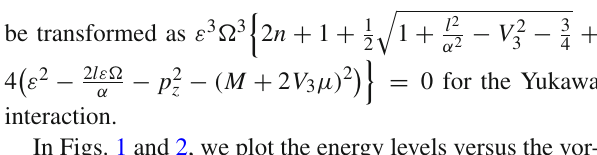
(cid:7)(cid:25) = 0 for the Yukawa μ) 2 3